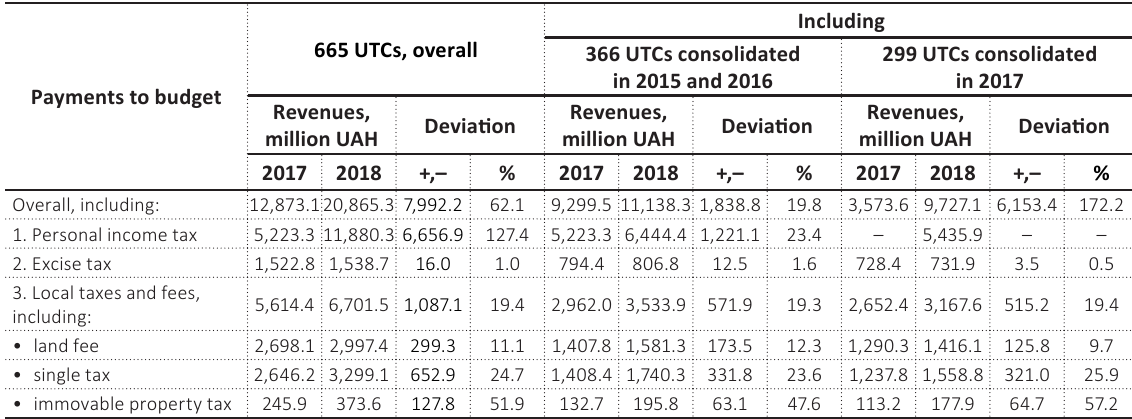
Table 1. Own income revenues of 665 UTCs in January-December 2018 compared to January-December